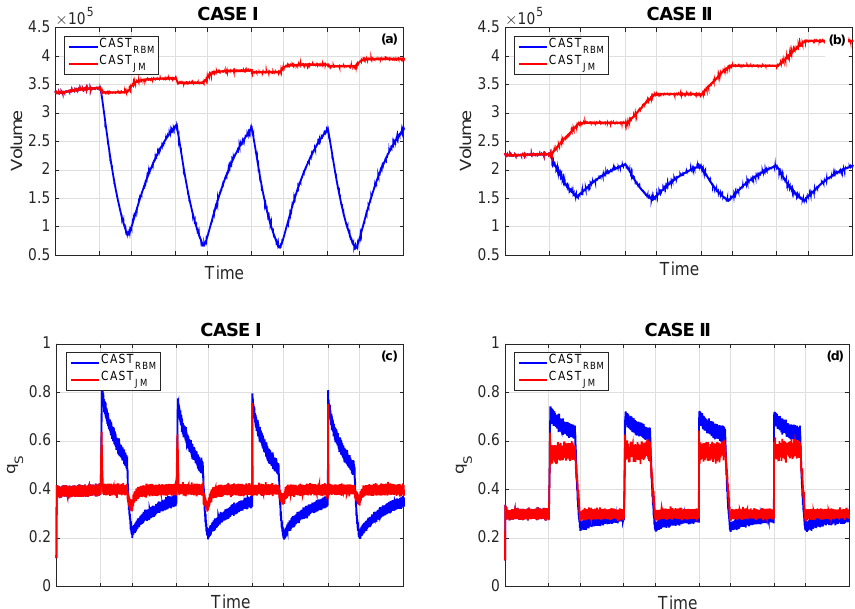
Figure 10. Unsteady simulations with four consecutive floods. (a) Time series of storage volume for the constant input case. (b) Time series of storage volume for the variable input case. (c) Time series of specific sediment flux for the constant input case. (d) Time series of specific sediment flux for the variable input